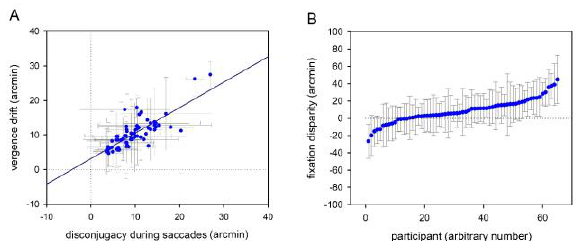
Figure 2. Binocular coordination during reading: Scatterplots showing (A) the correlation between disconjugacy during saccades and vergence drift during fixations and (B) mean fixation disparities for all participants. Exo fixation disparity is shown by negative values, while eso fixation disparity is reflected by positive values. Dots reflect mean values (arcmin) and grey whiskers show standard deviations (arcmin). The horizontal and vertical dotted lines mark zero values.